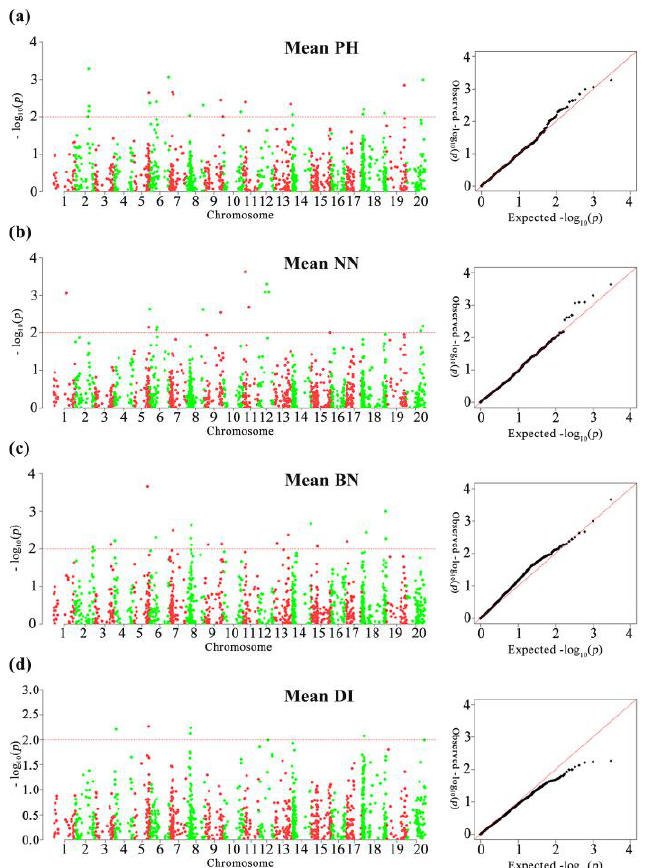
Figure 3. Manhattan and Q-Q plots of the GWAS for the four plant architecture-related traits in soybean mini core collection. The horizontal red line indicates the genome-wide significance threshold ( − log10( p ) ≥ 2). ( a – d ) Association mapping of PH, NN, BN, and DI based on the mean values of three environments, respectively.